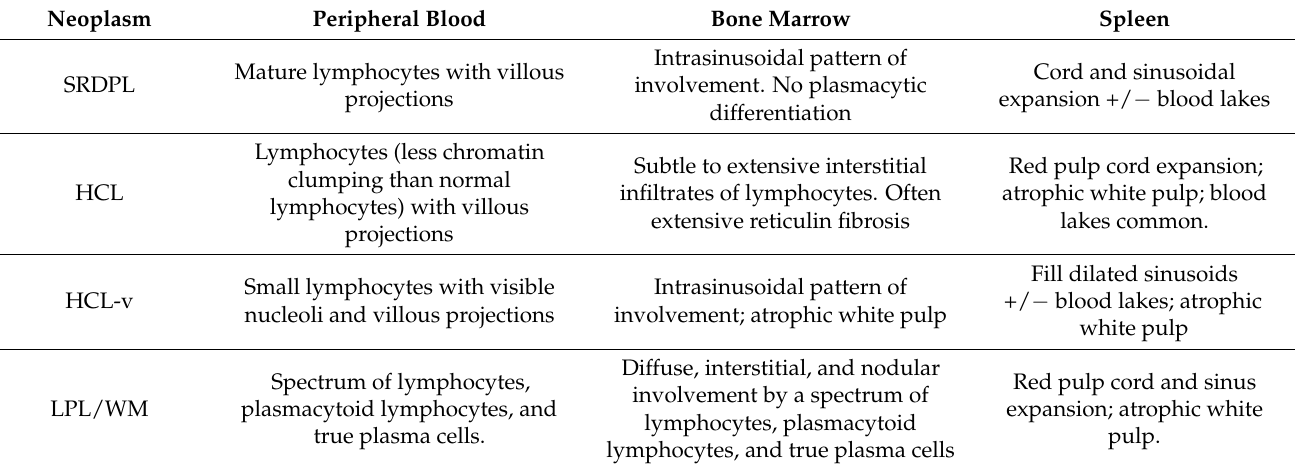
Table 3. Key morphologic features of CD5-CD10-LPDs,